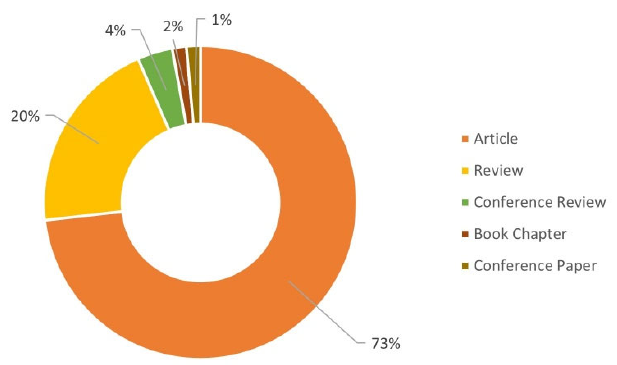
Figure 4. Publications classified according to the type of document.